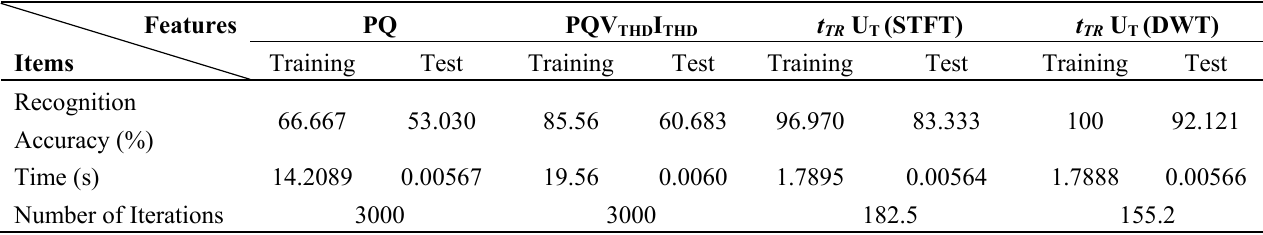
Table 2. The results of load identification in Case Study 2.